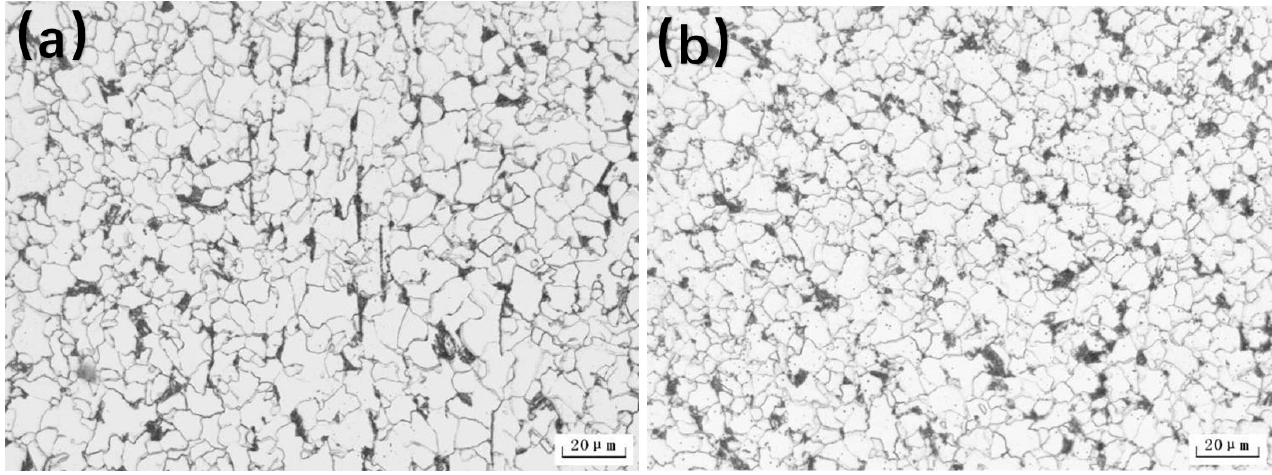
Figure 9. Microstructure of 1# pipe ( a ) welding zone; ( b ) heat-affected zone.